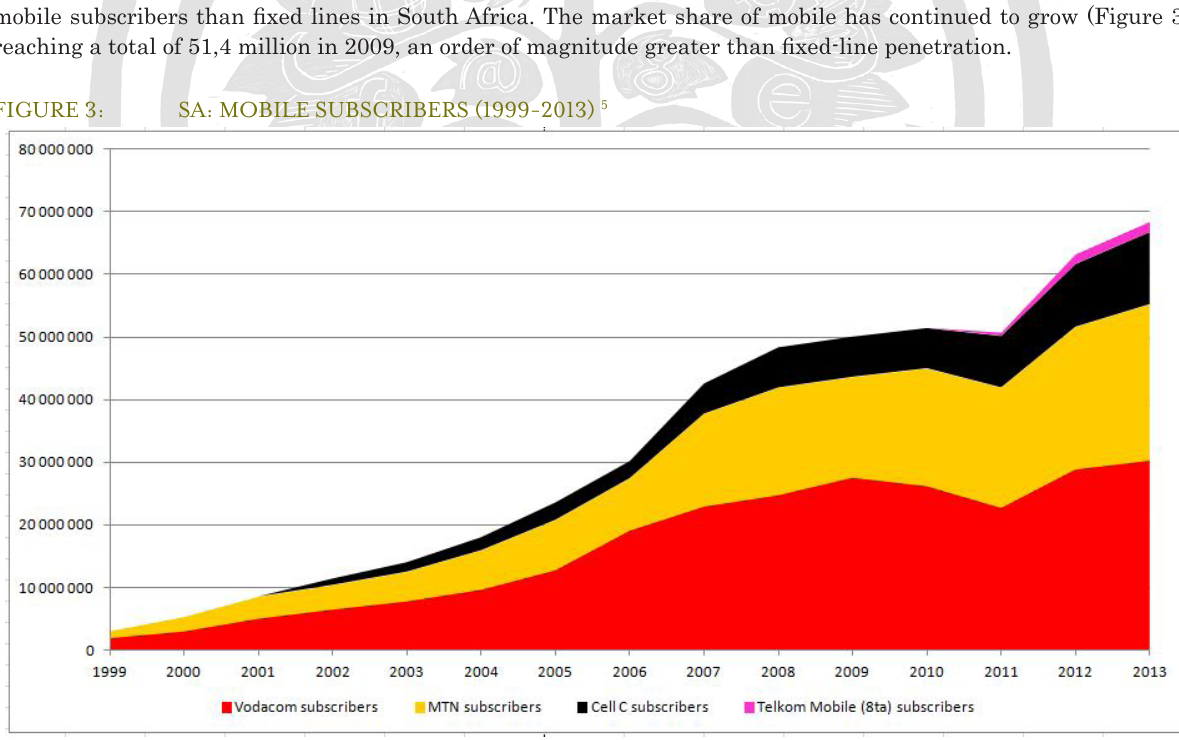
FIGURE 3: SA: MOBILE SUBSCRIBERS (1999-2013)